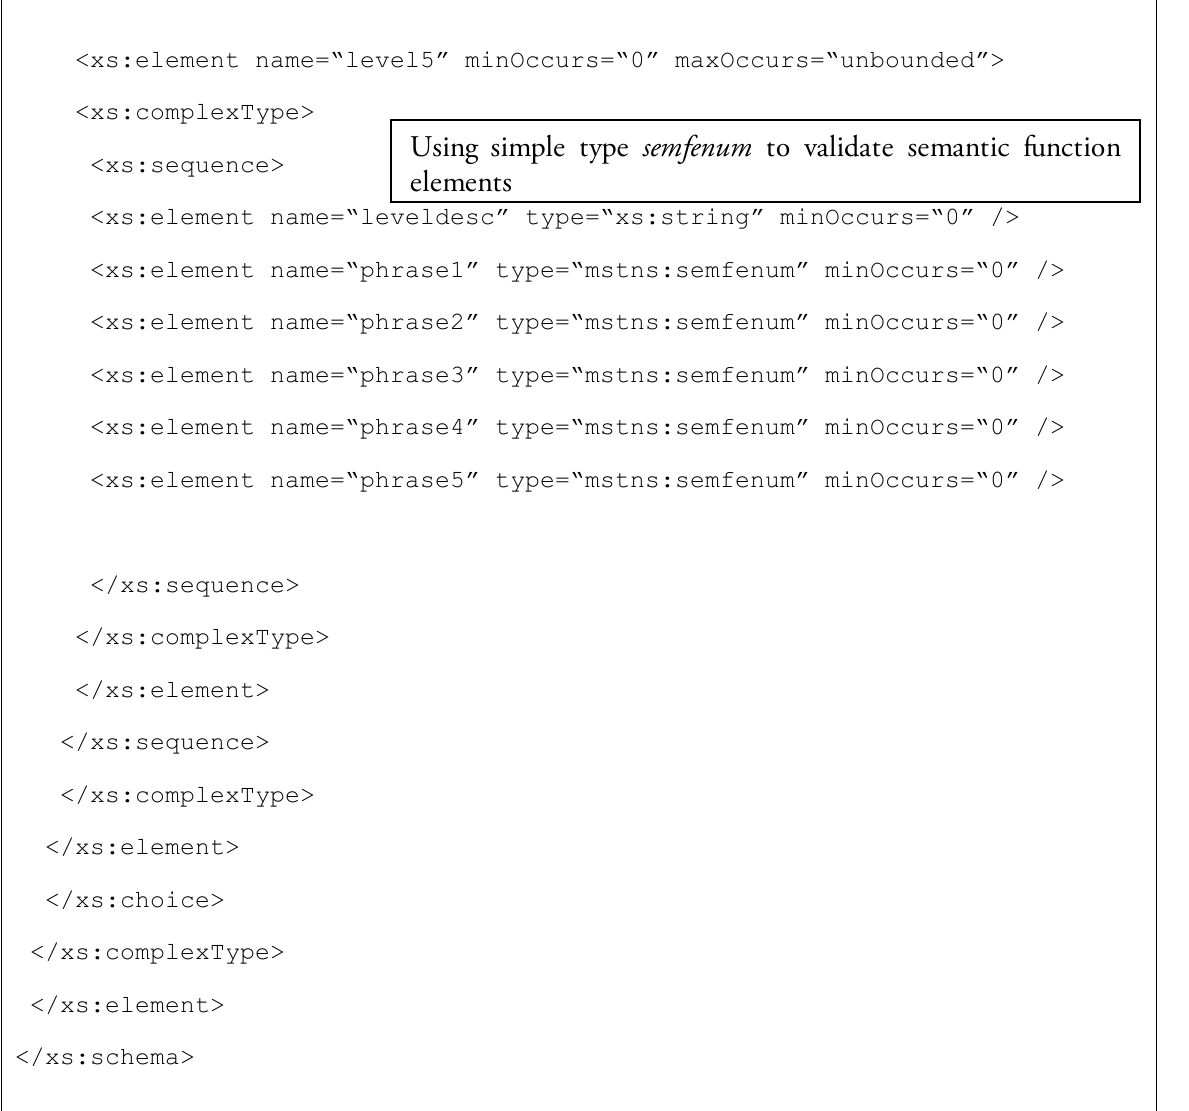
Figure 6. The XML Schema used to validate the XML database of Genesis 1:1-2:3.